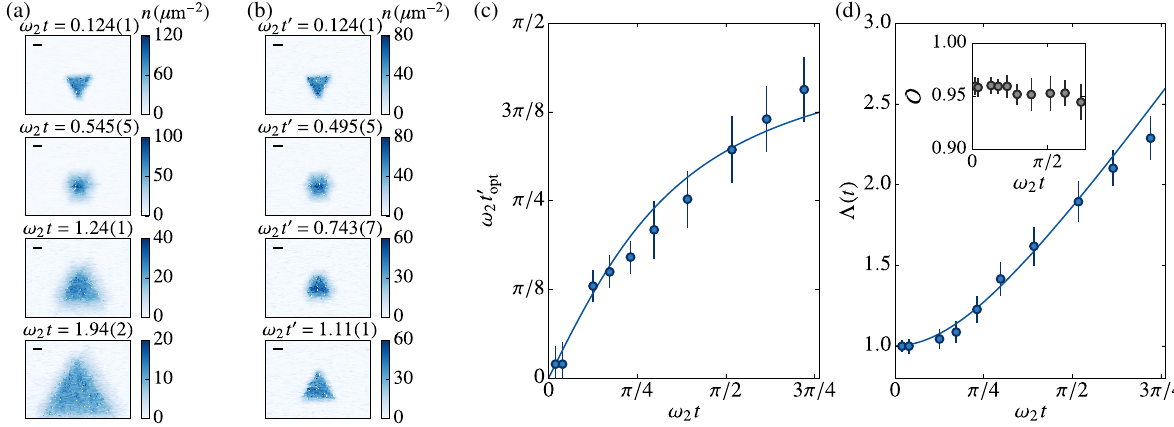
FIG. 2. Evolution of a gas with triangular shape [side length 40 . 2 ð 3 Þ μ m, 3 . 9 ð 3 Þ × 10 4 atoms] for two different values of the harmonic trapping frequency. (a),(b) Averaged images of the density distribution after a variable evolution time in the harmonic potential of frequency ω 1 ¼ 0 and ω 2 = 2 π ¼ 19 . 7 ð 2 Þ Hz, respectively. The images are an average over five to ten realizations, and the horizontal ð t Þ for black lines represent 10 μ m. Pairs of images with approximately corresponding evolution times are shown. (c) Optimal time t 0 opt which the overlap between images of the first and the second evolutions is maximum. (d) Optimal rescaling factor between the Þ . In the two graphs (c) and (d), the solid lines are the theoretical predictions given by Eqs. (13) corresponding images n 1 ð t Þ and n 2 ð t 0 opt and (14). The inset of (d) presents the overlap between the corresponding images of the two series. In (c) and (d), the error bars indicate the confidence intervals within 2 standard deviations of the fits used to reconstruct the scaling